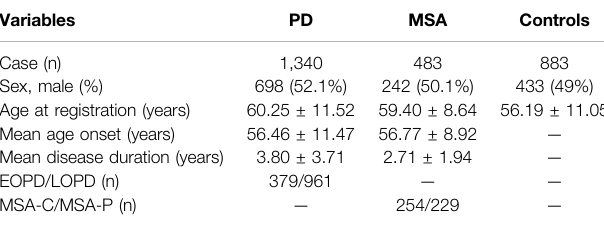
TABLE 1 | Demographic and clinical characteristics of the patients and controls.